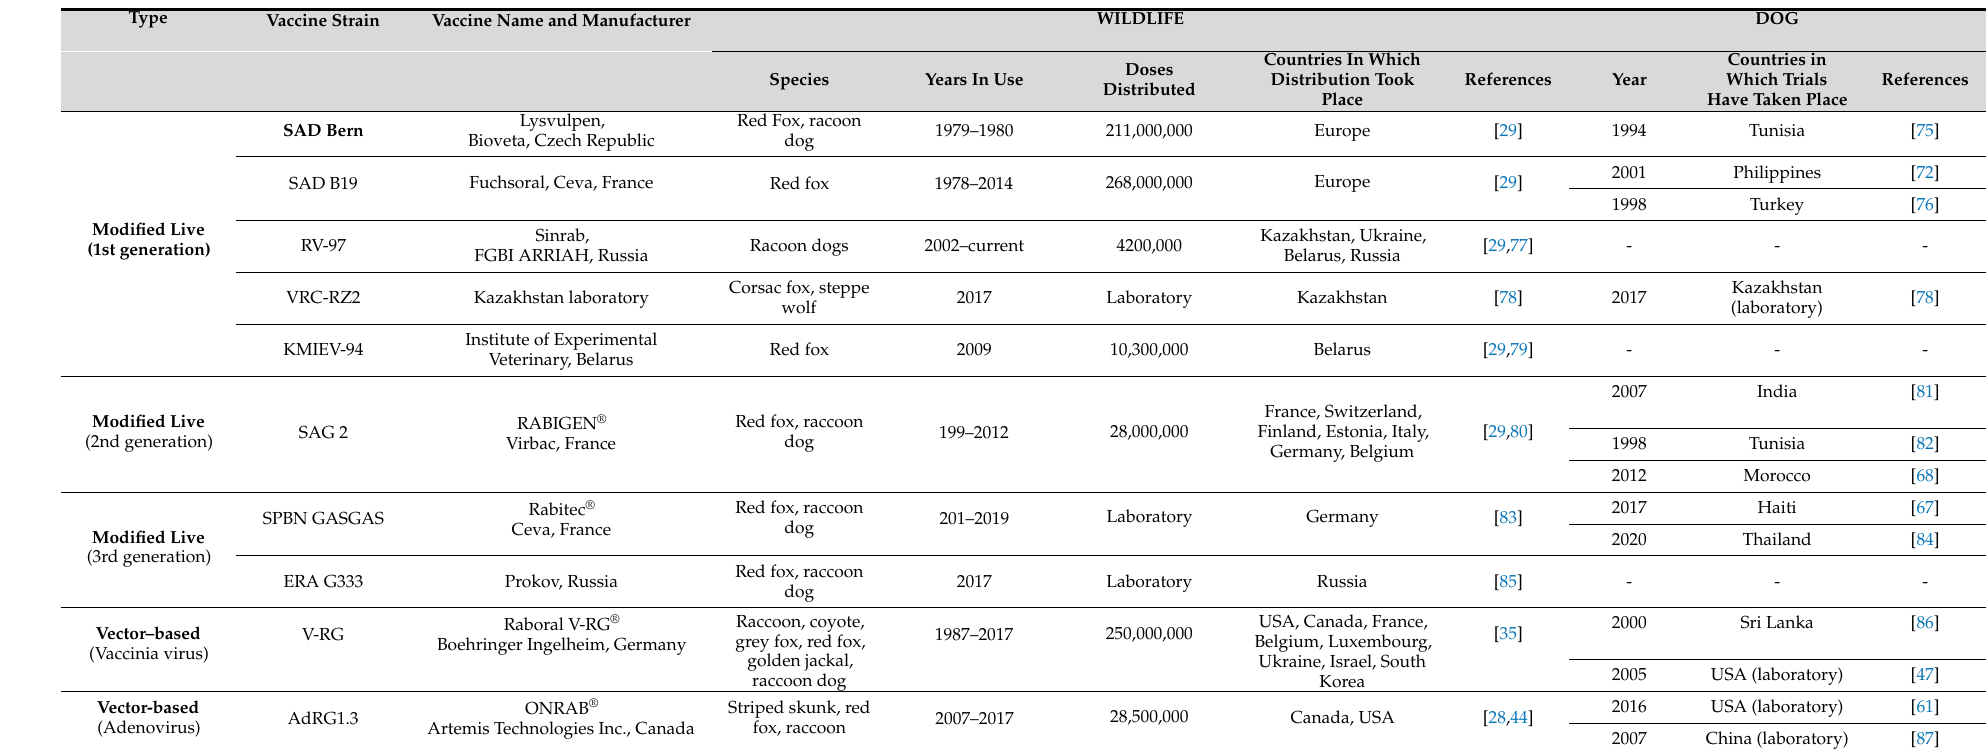
Table 1. List of ORV used in wildlife and trialed in